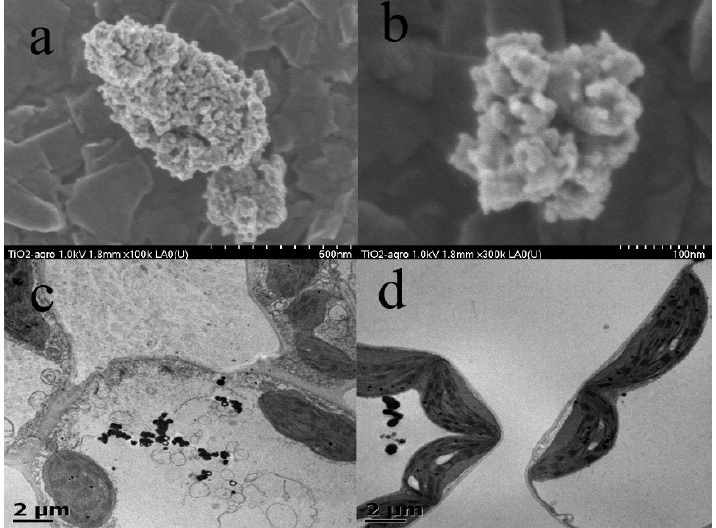
Figure 1. TiO 2 NPs at a scale of 500 nm ( a ) and 100 nm ( b ); absorption and distribution of TiO 2 NPs in leaves of C. annuum ( c , d ).